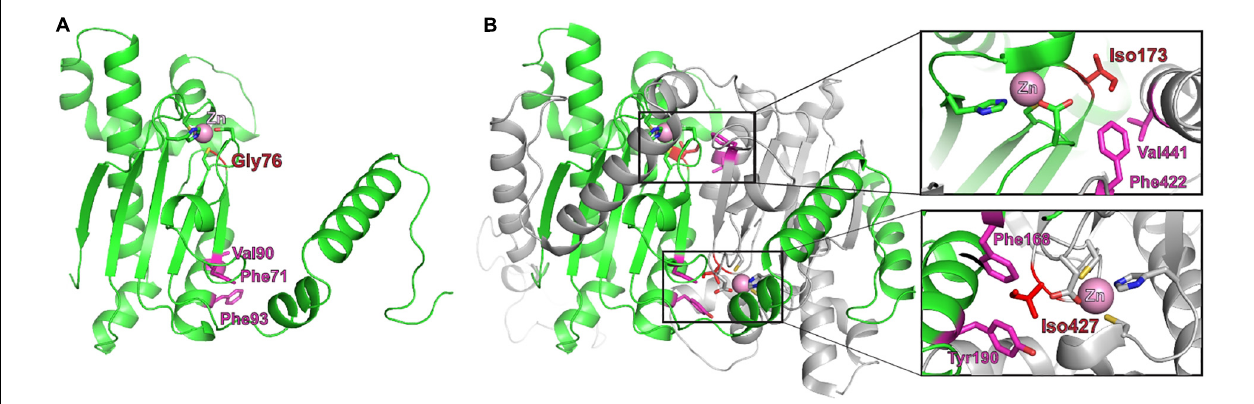
FIGURE 3 | Structural model of Brucella Ba2308 CAI. (A) Predicted structure of a monomer of Q2YL41, the CA I from Brucella abortus 2308, created using Phyre2, and the structure from the β -carbonic anhydrase from the red alga Porphyridium purpureum (1ddz) as template. Gly76 is depicted in red and the nearby zinc atom as a pink ball. (B) X-ray structure of the P. purpureum monomer, composed of two internally repeated structures. The N-terminal half (residues 1–308, equivalent to the sequence of monomeric Ba2308 CAI) is in green, and the C-terminal half (residues 309–564, equivalent to the second molecule of a putative dimer from Ba2308 CAI) is in gray. In the equivalent position of Gly76 from Ba2308 CAI in P. purpureum is located Iso173 (in the N-terminal half) or Iso427 (in the C-terminal half). These residues are establishing hydrophobic contacts in the interface between the domains; Iso173 with Val441 and Phe442 (upper zoom image) and Iso427 with Phe168 and Tyr190 (lower zoom image). Identical (Phe71 and Val90) and similar (Phe93) residues are located in the equivalent positions in Brucella Ba2308 CAI (A) . The presence of a glycine in Brucella Ba2308 CAI instead of an isoleucine disrupts these hydrophobic interactions and could impair dimerization. Besides, this substitution could alter locally the folding of this region and affect the nearby residues that are coordinating the Zn atom.